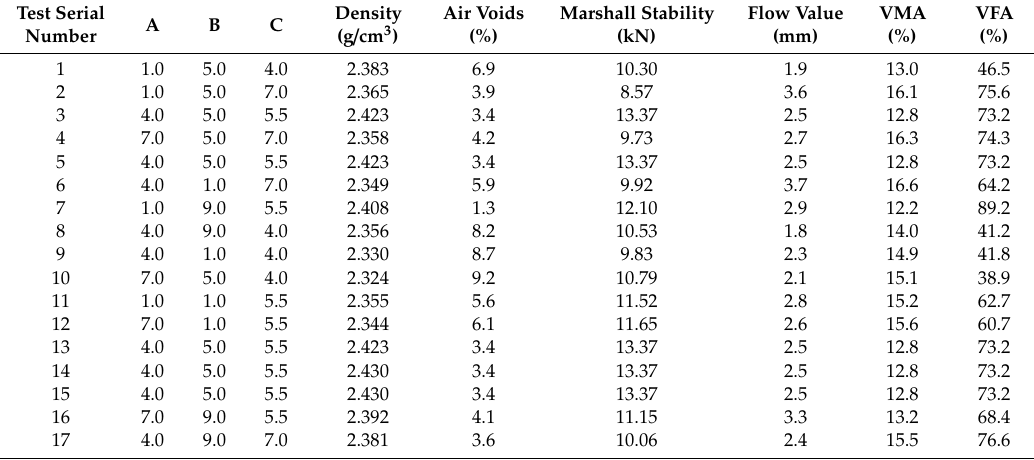
Table 8. Marshall test results. VMA, voids in mineral aggregate; VFA, voids filled with asphalt.